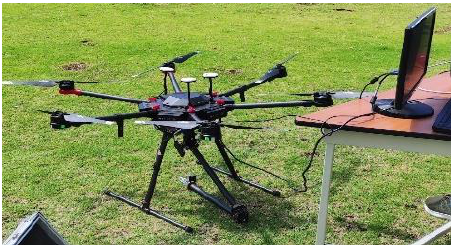
Figure 9. DJI Matrice 600 Pro UAV provided by the ARSI research group.